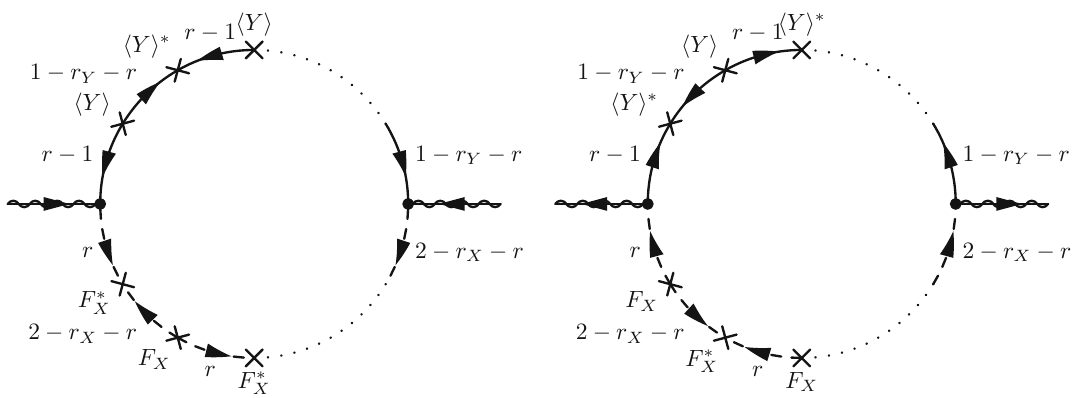
Fig. 5 Possible one-loop diagrams for the gaugino mass with multiple vertices inserted, with R-charges of messenger components determined from R-charge conservation. The two diagrams are conjugate to each other, and both should be included as Majorana mass terms